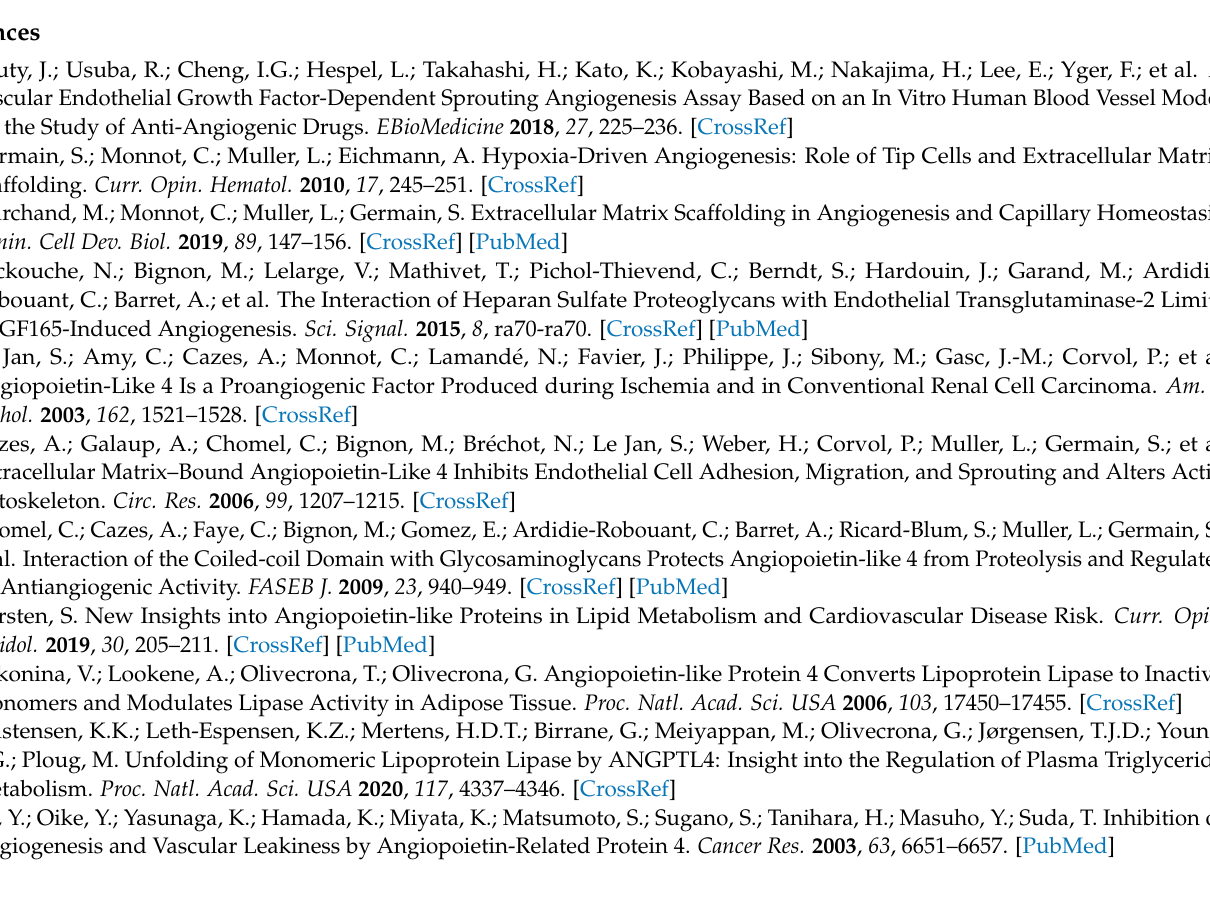
Figure S4: Protein amount of adherens junction components. Figure S5: Protein amount of VEGFR2 for short- and long-term stimulations. Video S1: Three-dimensional reconstruction of the endothelial capillary network sprouting from a bead in fibrin